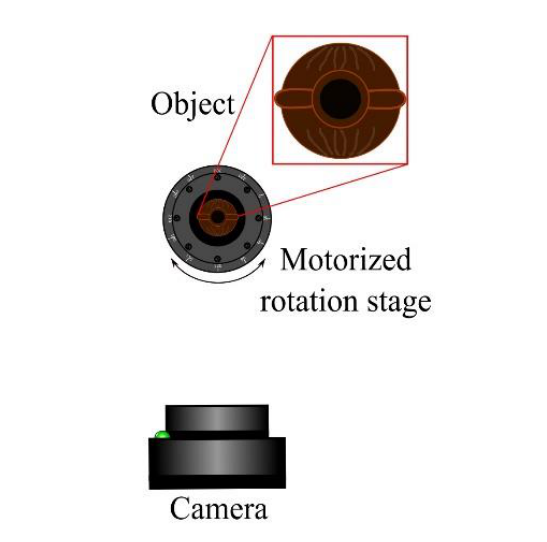
Figure 3. The setup of object digitization, top view.